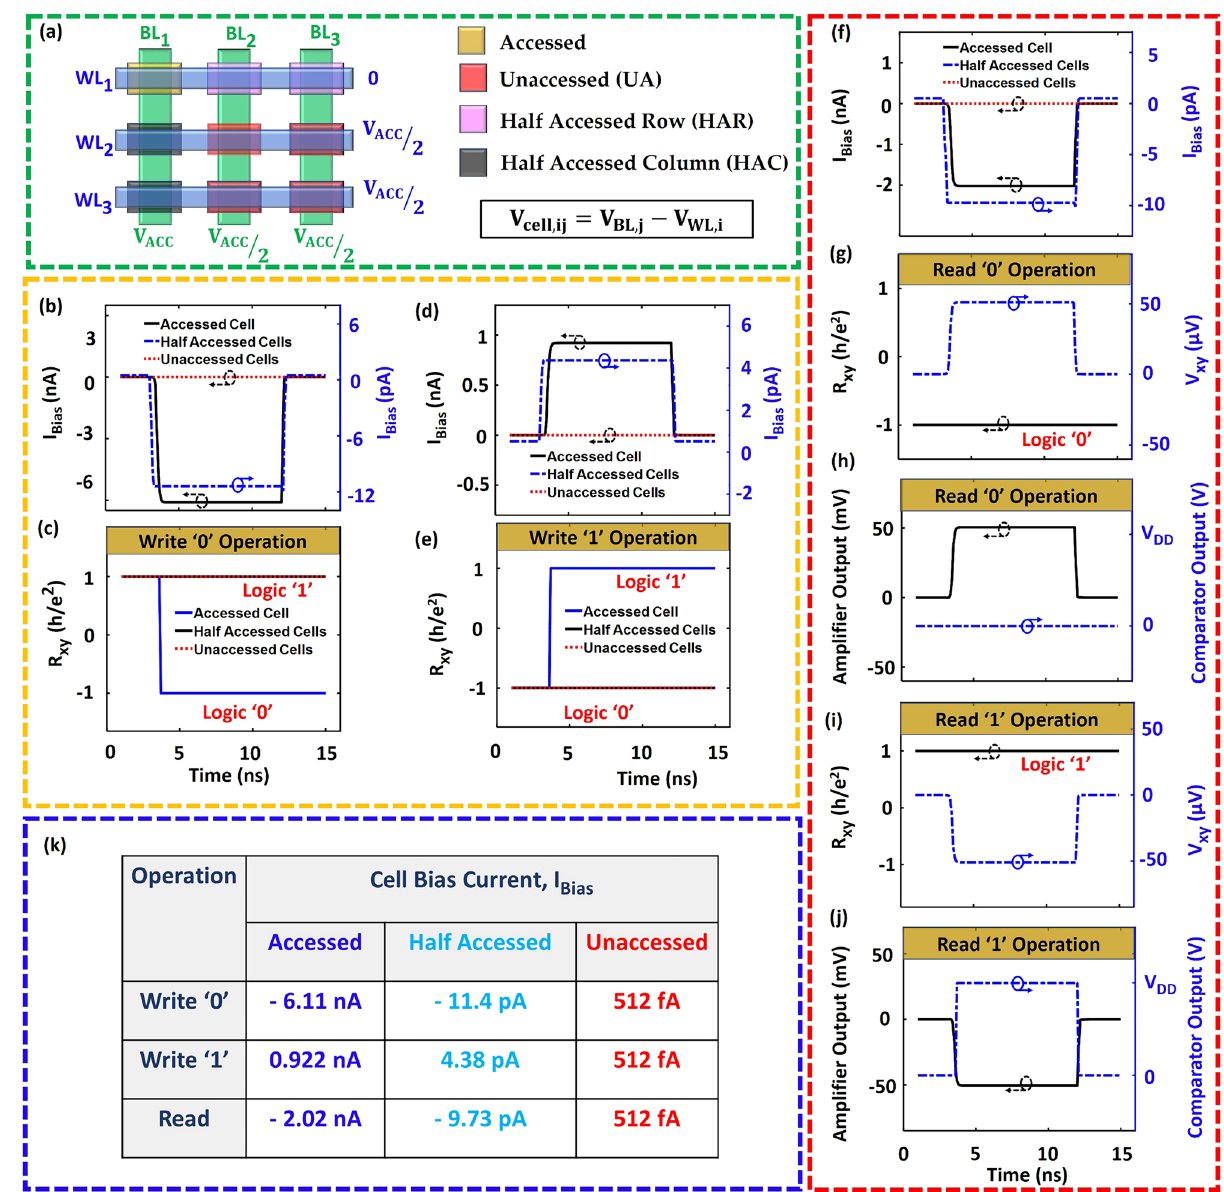
Figure 4. Compilation of the simulation results for the memory array. ( a ) Arrangement and types of memory cells in a conventional cross-point memory array under the V/2 biasing scheme. Write ‘0’ operation : ( b ) Cell Bias currents ( I Bias ) through different memory cells generated by applying appropriate V ACC (c) The time dynamics of the Hall resistance ( R xy ) illustrating state transition only in the accessed cell. Write ‘1’ operation : ( d ) I Bias with different magnitude and opposite polarity (compared with the write ‘0’ case) flowing through different memory cells ( e ) Corresponding transition in R xy . Read operation : ( f ) The I Bias is of the same polarity as the write ‘o’ operation, but has ~ 3X lower magnitude. The peripheral circuits (amplifier and comparator) are enabled only during this period. The comparator output is always initialized at zero volage. ( g ) If the memory cell holds binary ‘0’, the Hall voltage ( V xy ) exhibits a positive polarity during the read operation. R xy remains unchanged throughout the process. ( h ) The amplified V xy is fed into a comparator which produces a digital output. While reading ‘0’, the comparator output remains unchanged at its initial value (0 V). ( i ) Read ‘1’ operation produces the opposite polarity in V xy , and R xy remains unchanged. ( j ) The amplified V xy triggers a 0 → V DD transition in the comparator output, which remains stable throughout the read